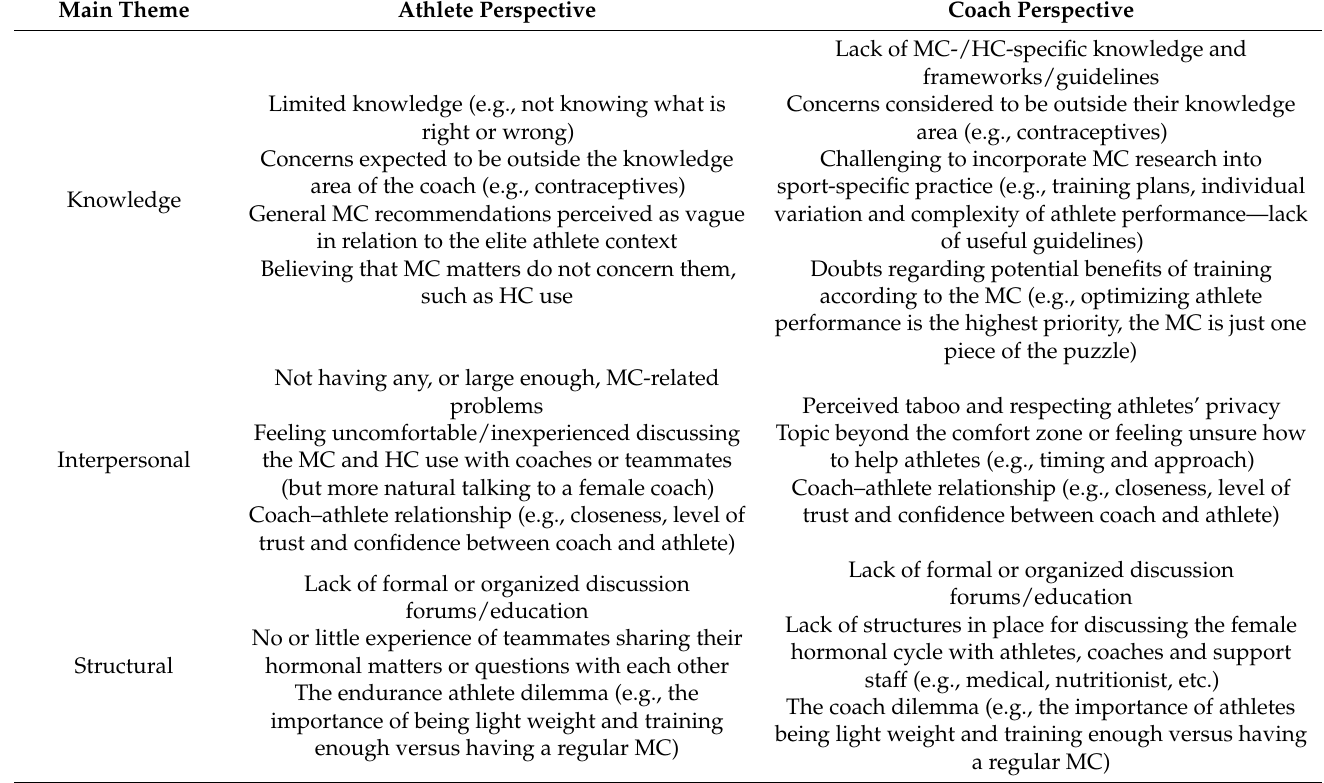
Table 3. Higher-order themes of barriers to communication related to the female hormonal cycle derived from the focus- group interviews with the athletes and coaches. Main